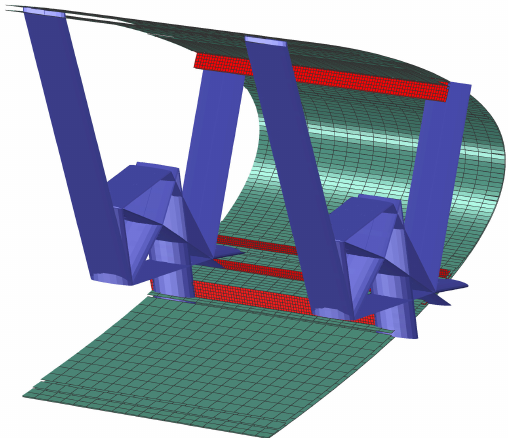
Figure 15. Finite element model used by the third level of